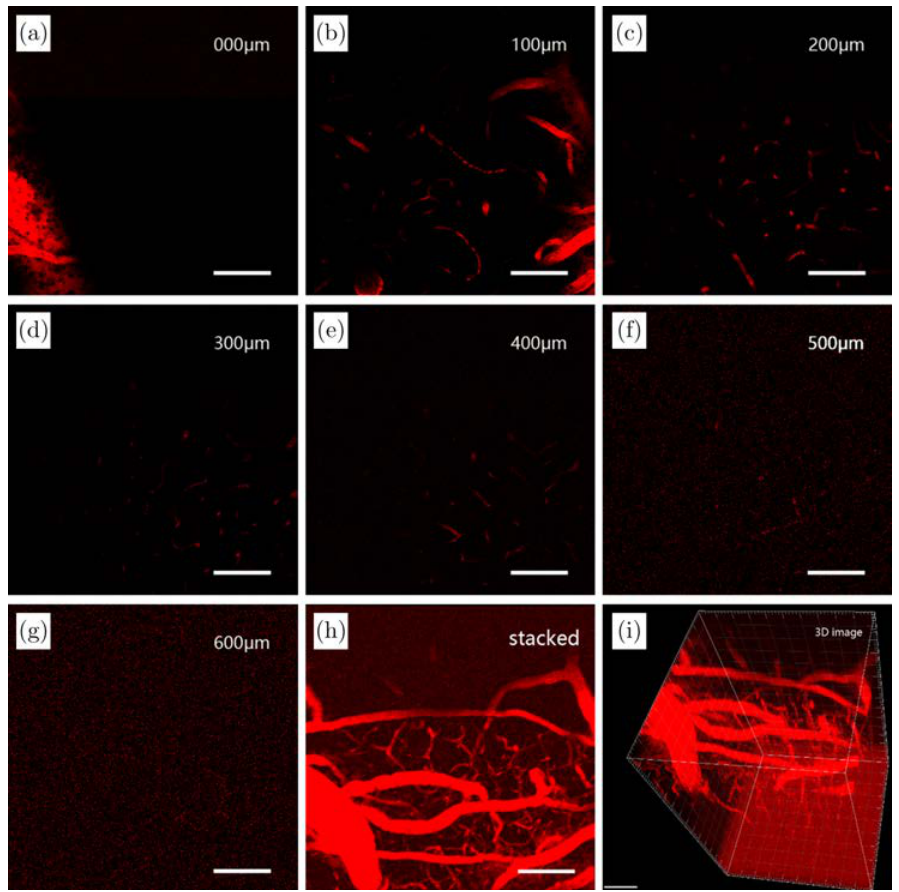
Fig. 9. In vivo 3PFM imaging of brain vasculature of a rat injected with DCDPP-2TPA NPs. Each image taken at di®erent depths from 0 – 600 (cid:1) m (a) – (g). (h) A stacked three-photon °uorescence image from a depth of 0 (cid:1) m to 600 (cid:1) m. (i) A reconstructed 3D image showing the blood vessels of rat brain stained by DCDPP-2TPA NPs. Scale bar: 100 (cid:1)